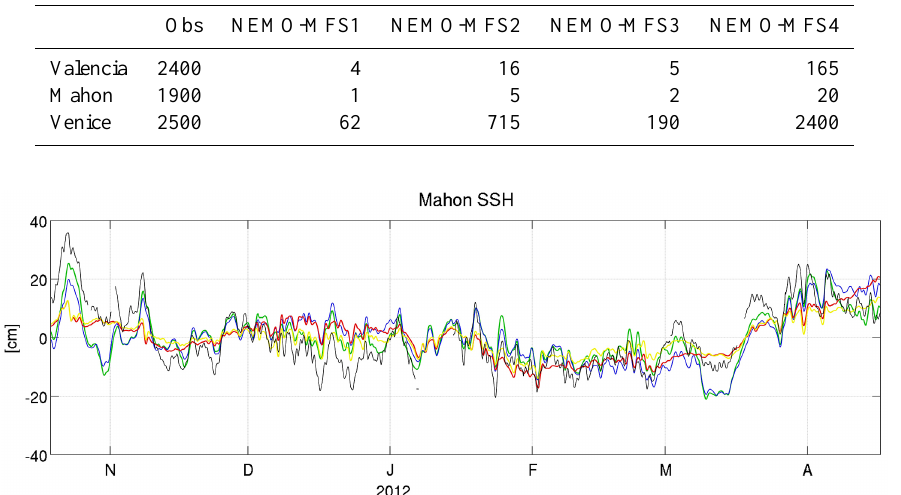
Figure 8. Mahon η time-series from observations and model results. Data and model results have been filtered with 5h running mean. Observations, black; NEMO-MFS1, red; NEMO-MFS2, blue; NEMO-MFS3, yellow; NEMO-MFS4, green.